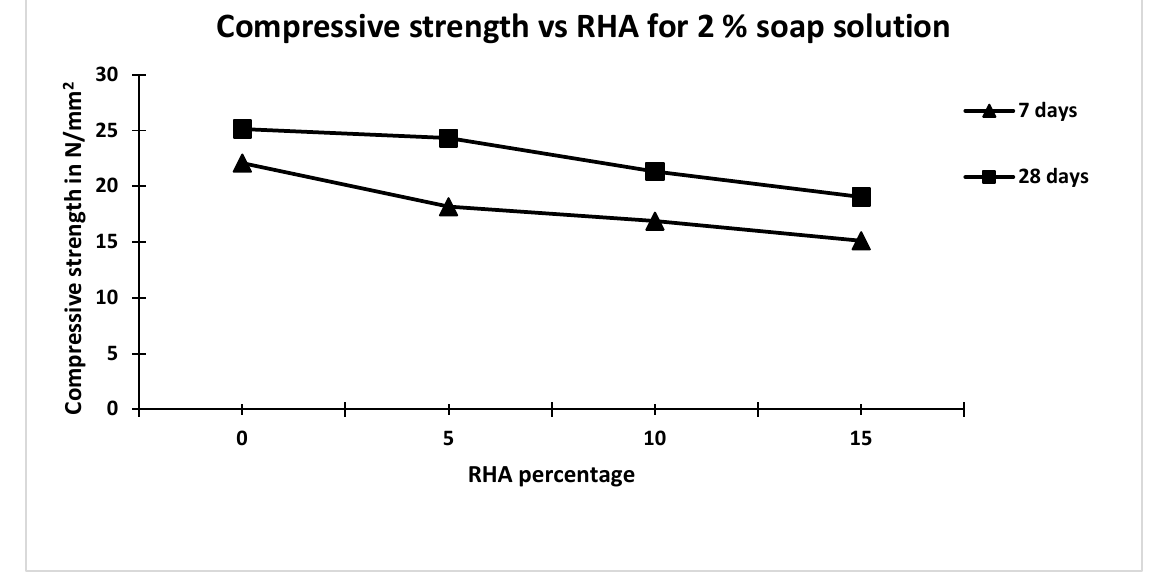
Figure 4. Graph between compressive strength and RHA for 2 % soap solution. Table 4. Carbonation depth, carbonation rate coefficient and coefficient of permeability of different concrete mixes.